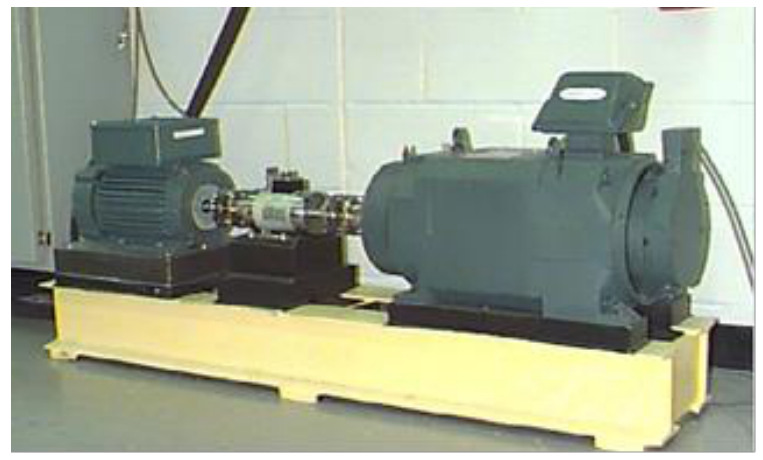
Figure 4. Bearing test device.